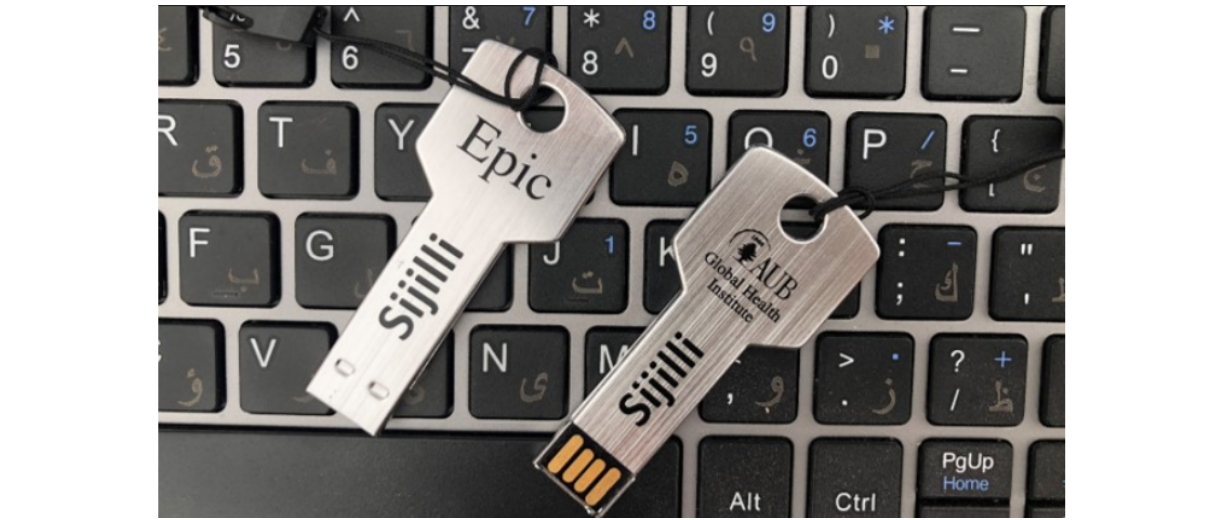
Figure 1. The key-shaped USB containing the Sijilli electronic health record handed to the